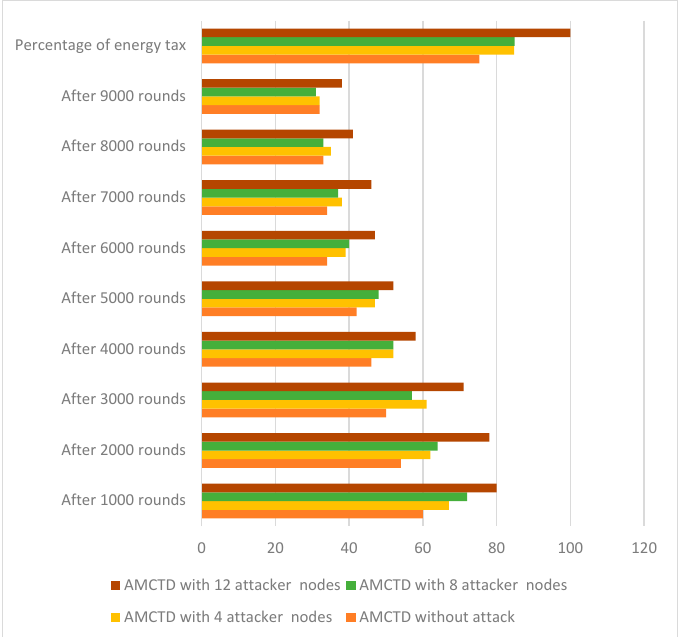
Figure 11. Energy Tax of AMCTD without Attack, AMCTD with 4, 8 and 12 Attacker Nodes.